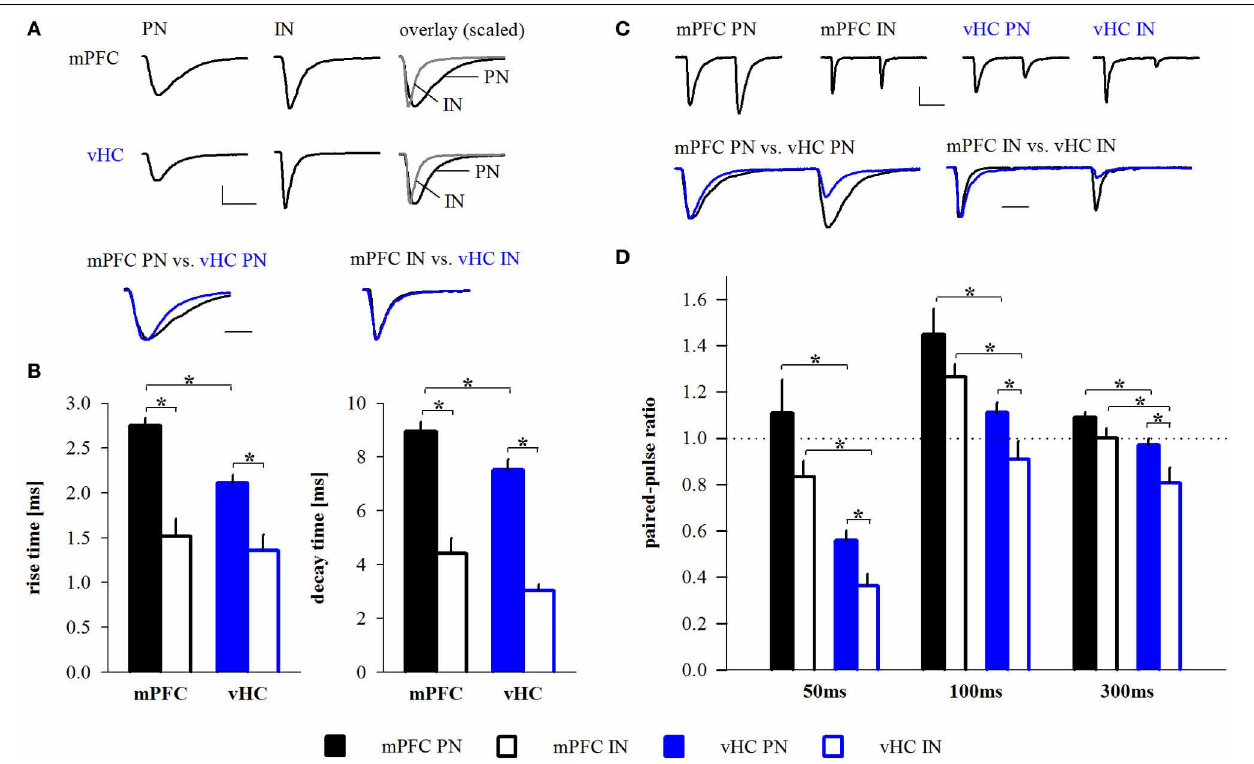
FIGURE 6 | Properties of mPFC- and vHC-evoked EPSCs in BA neurons. (A) Example traces of EPSCs recorded at − 70mV in BA principal neurons (PN) and interneurons (IN) receiving input from mPFC (top) or vHC (middle) and amplitude-scaled overlays showing faster rise and decay of EPSCs in IN. Amplitude-scaled overlays of mPFC- or vHC-evoked EPSCs in PNs and INs show faster EPSCs of vHC inputs in PNs (bottom). Scale bars: 100pA/10ms (top) and 5ms (bottom). (B) Summary graphs for rise and decay times of EPSCs in PNs and INs for mPFC (black) and vHC inputs (blue), all values are in Table 2 (all PNs) and Table 5 (all INs). Rise and decay times were significantly faster for mPFC inputs onto INs vs. PNs (rise time: p < 0 . 001; decay time: p < 0 . 001) and vHC inputs onto INs vs. PNs (rise time: p = 0 . 002; decay time: p < 0 . 001). vHC inputs evoked faster EPSCs in PNs than mPFC inputs